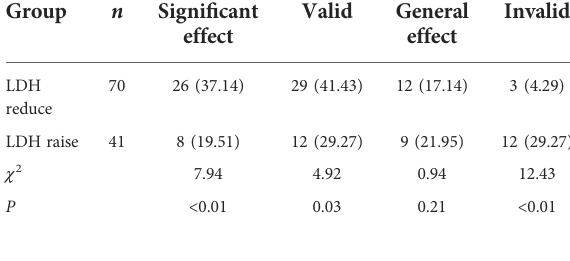
TABLE 4 Comparison of curative effects of patients with decreased or increased serum LDH 3 years after operation